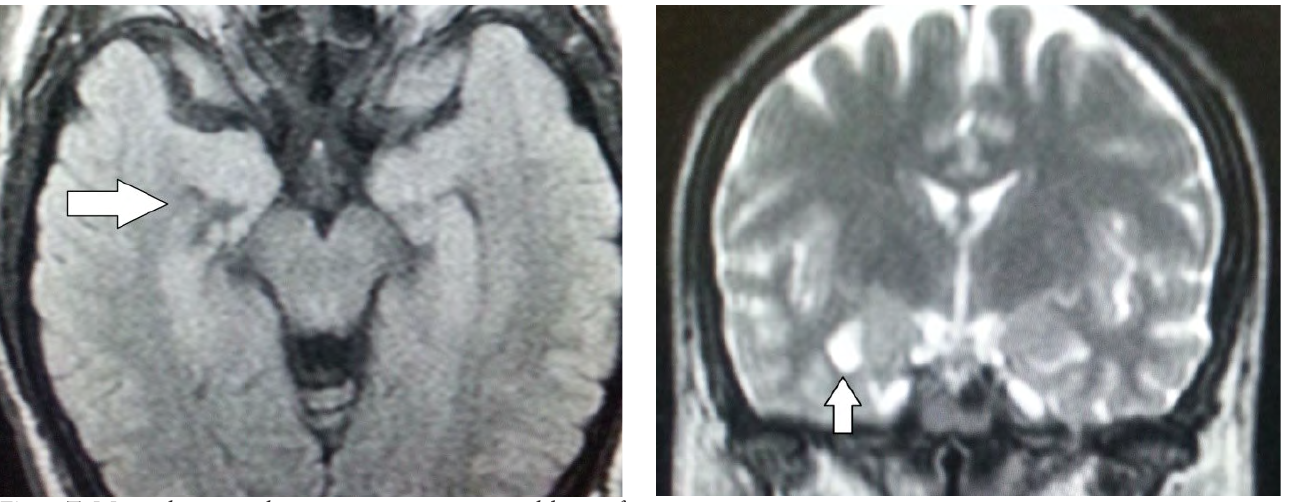
Fig 1 : T1W axial section showing prominent temporal horn of right lateral ventricle along with prominent CSF spaces in the ipsilateral medial temporal lobe (hippocampal/parahippocam- pal region) suggestive of atrophy of medial temporal lobe. Arrow shows the dilated and prominent CSF space in the right medial temporal lobe